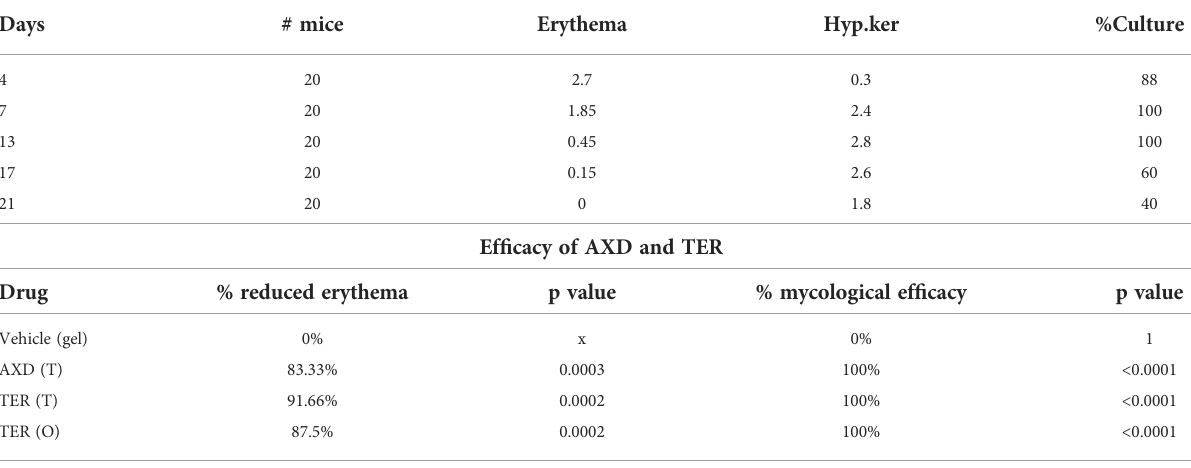
TABLE 1 Clinical and mycological assessments of infection during model establishment and after antifungal drug treatment. Infection progression in diabetic